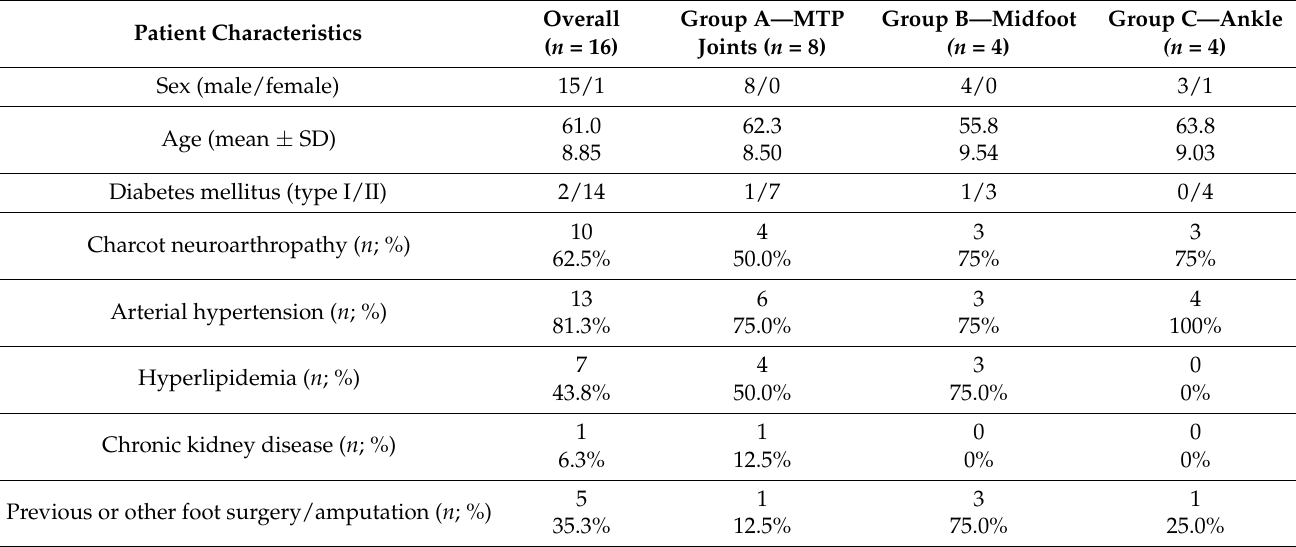
Table 1. Patient population: demographic information and characteristics.